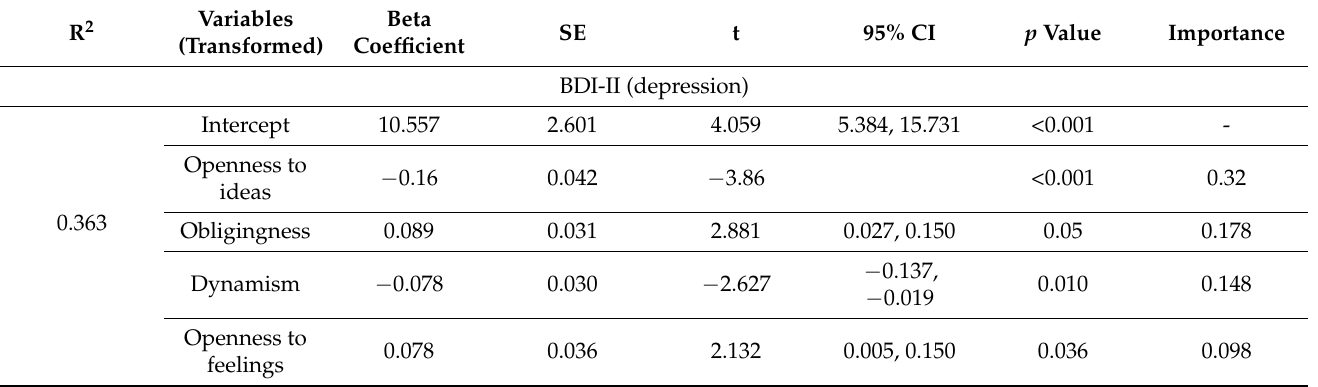
Table 4. Automatic linear modelling analysis assessing the personality predictors of depression and anxiety.